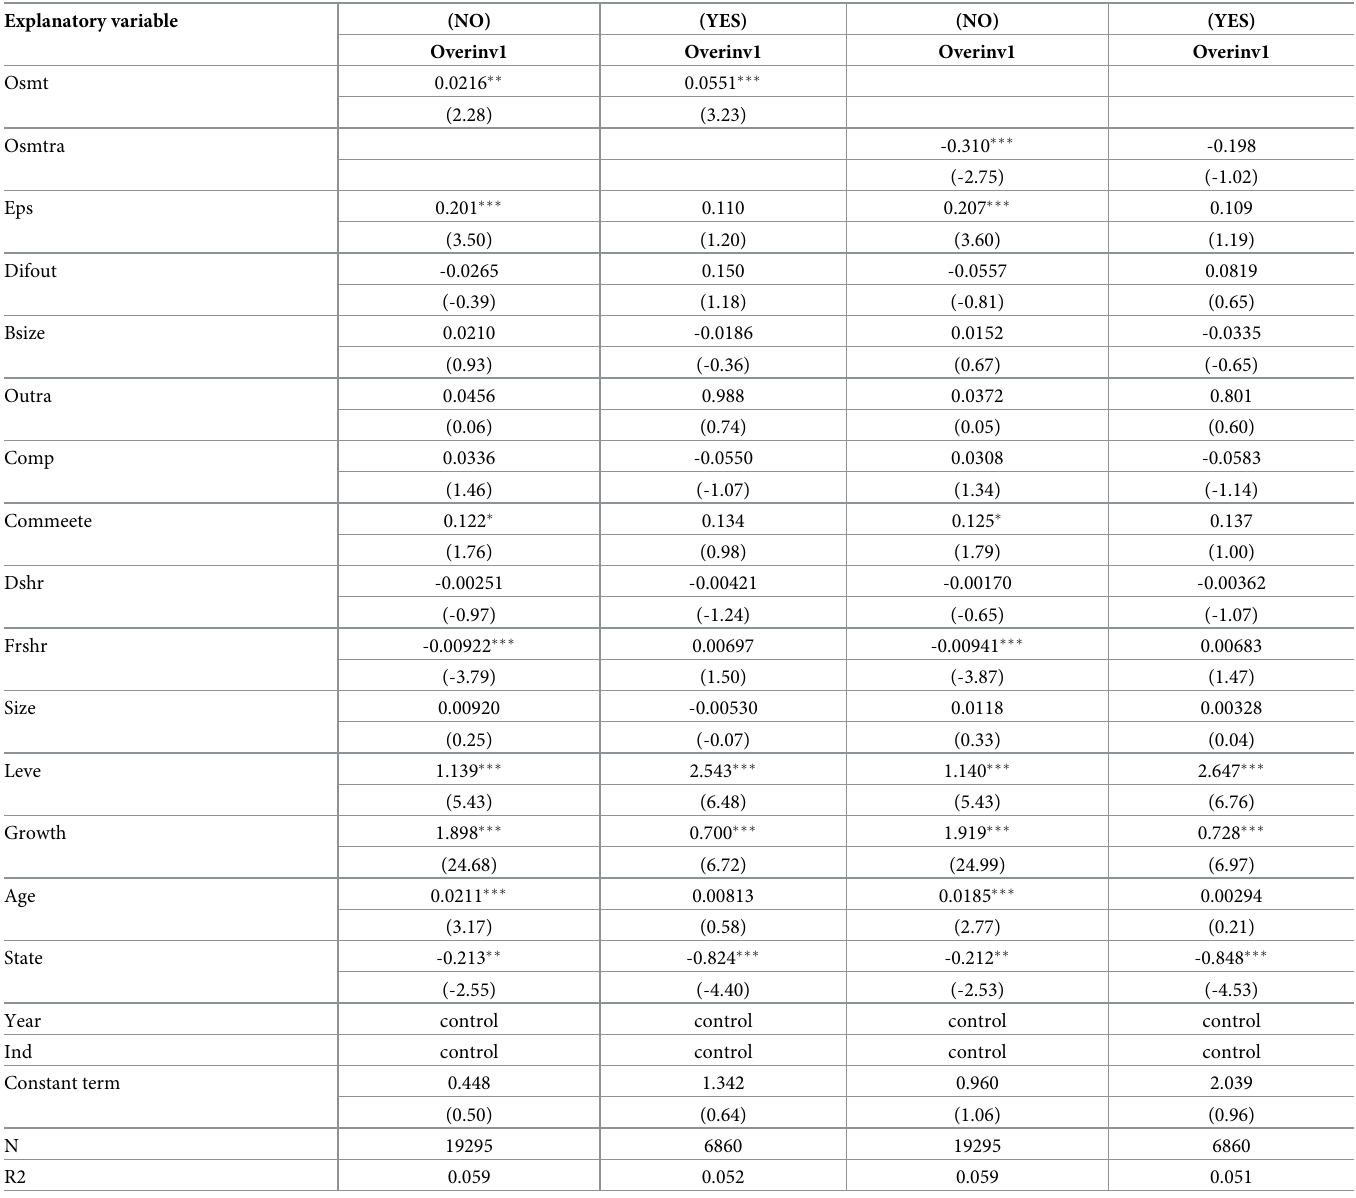
Table 5. The company is duality or